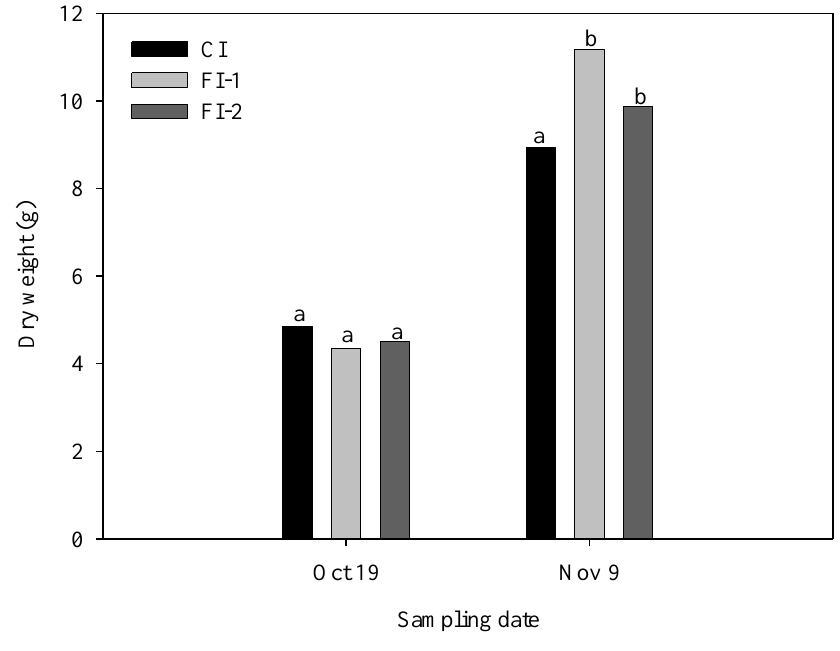
FIGURE 3. Comparisons of dry weight of stems among treatments at different sampling dates. Different letters at the top of the bars indicate significant difference ( p <